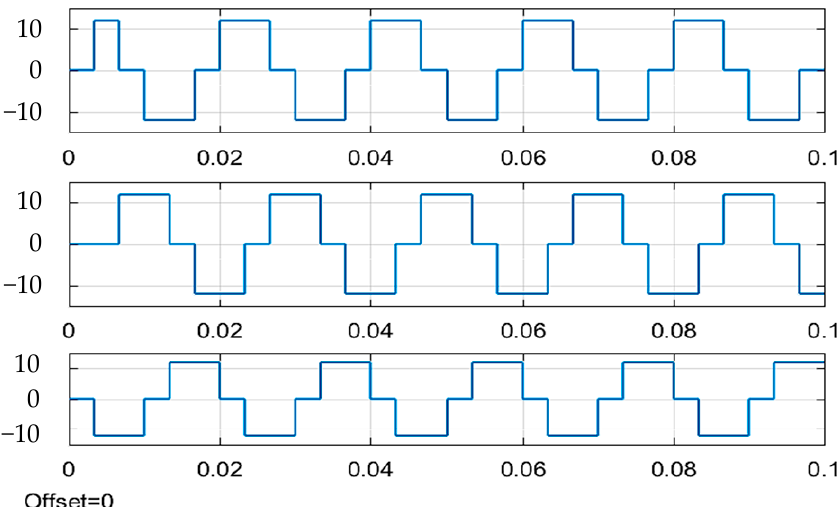
Figure 10. Phase voltage waveform at 120° [41].